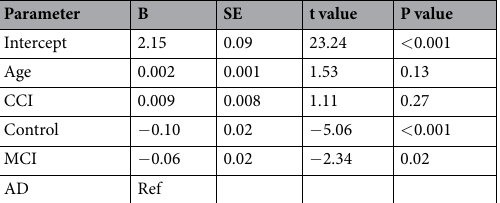
Table 2. Results of one-way analysis of covariance (ANCOVA) analyzing the differences in baseline plasma MCP-1 levels between the 3 patient groups. Dependent variable: plasma MCP-1 level (log transformation).